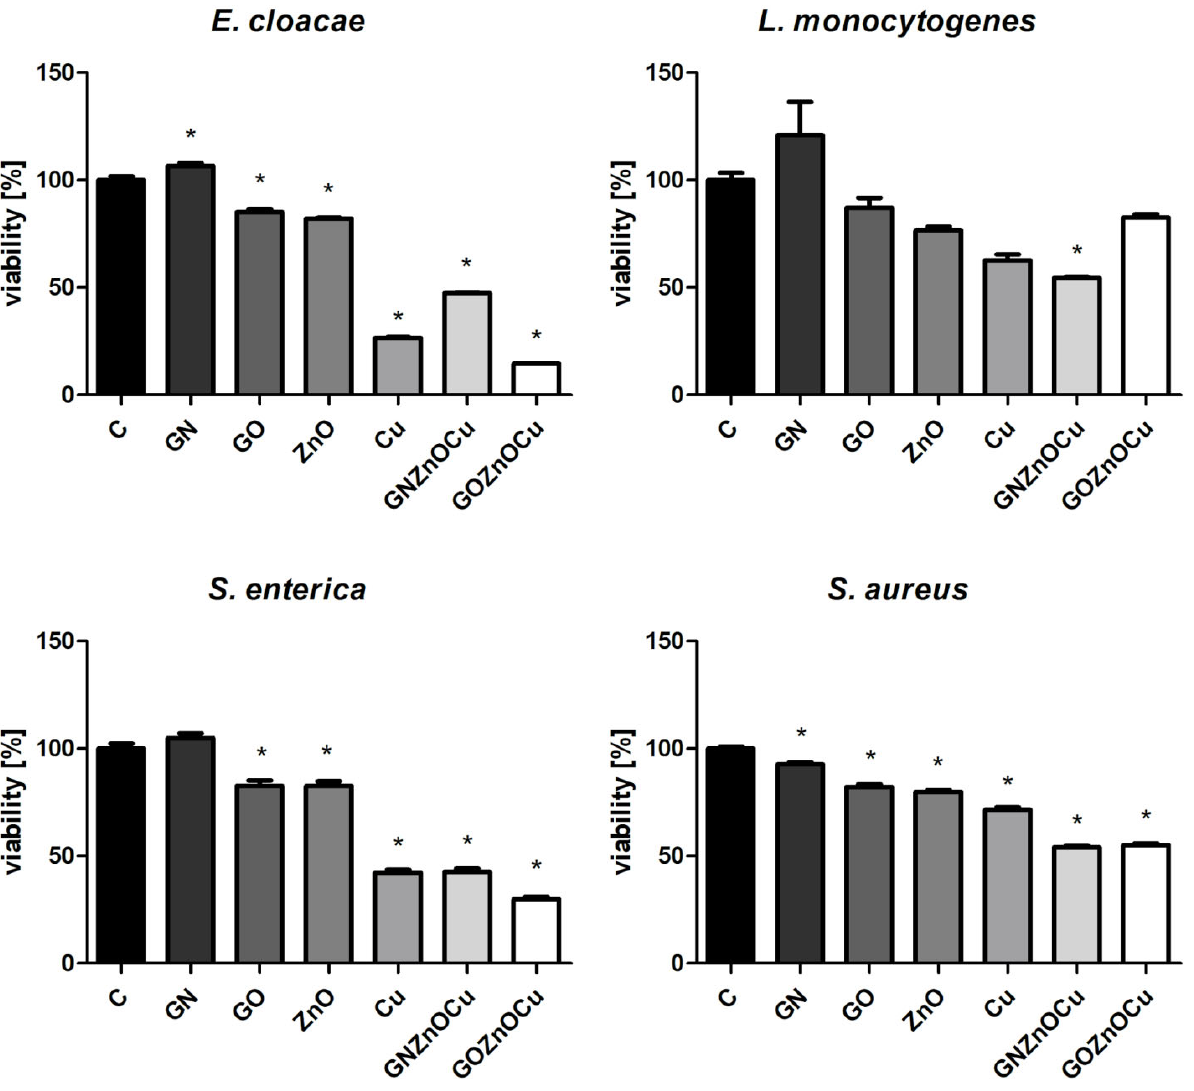
Figure 4. Viability of bacteria after treatment with nanoparticles. C is the control sample, and the results are mean values ± standard deviation. “*” symbols indicate statistically significant differences in comparison to the control.